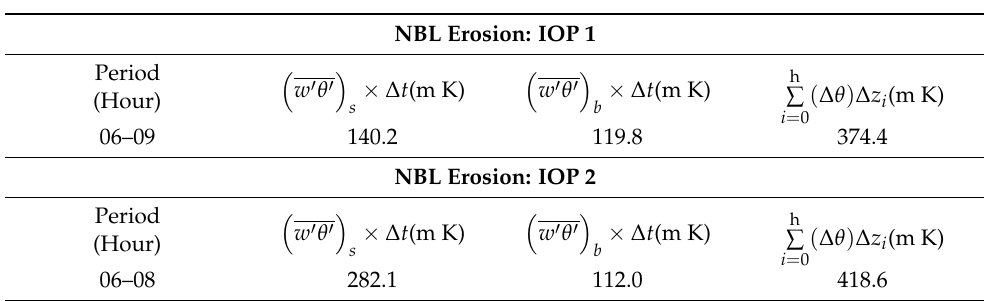
Table 1. Integrated total heat flux for the NBL erosion period on the surface ( (cid:16) (cid:17) × ∆ t ), and layer heating ( w (cid:48) θ (cid:48) flux ( b